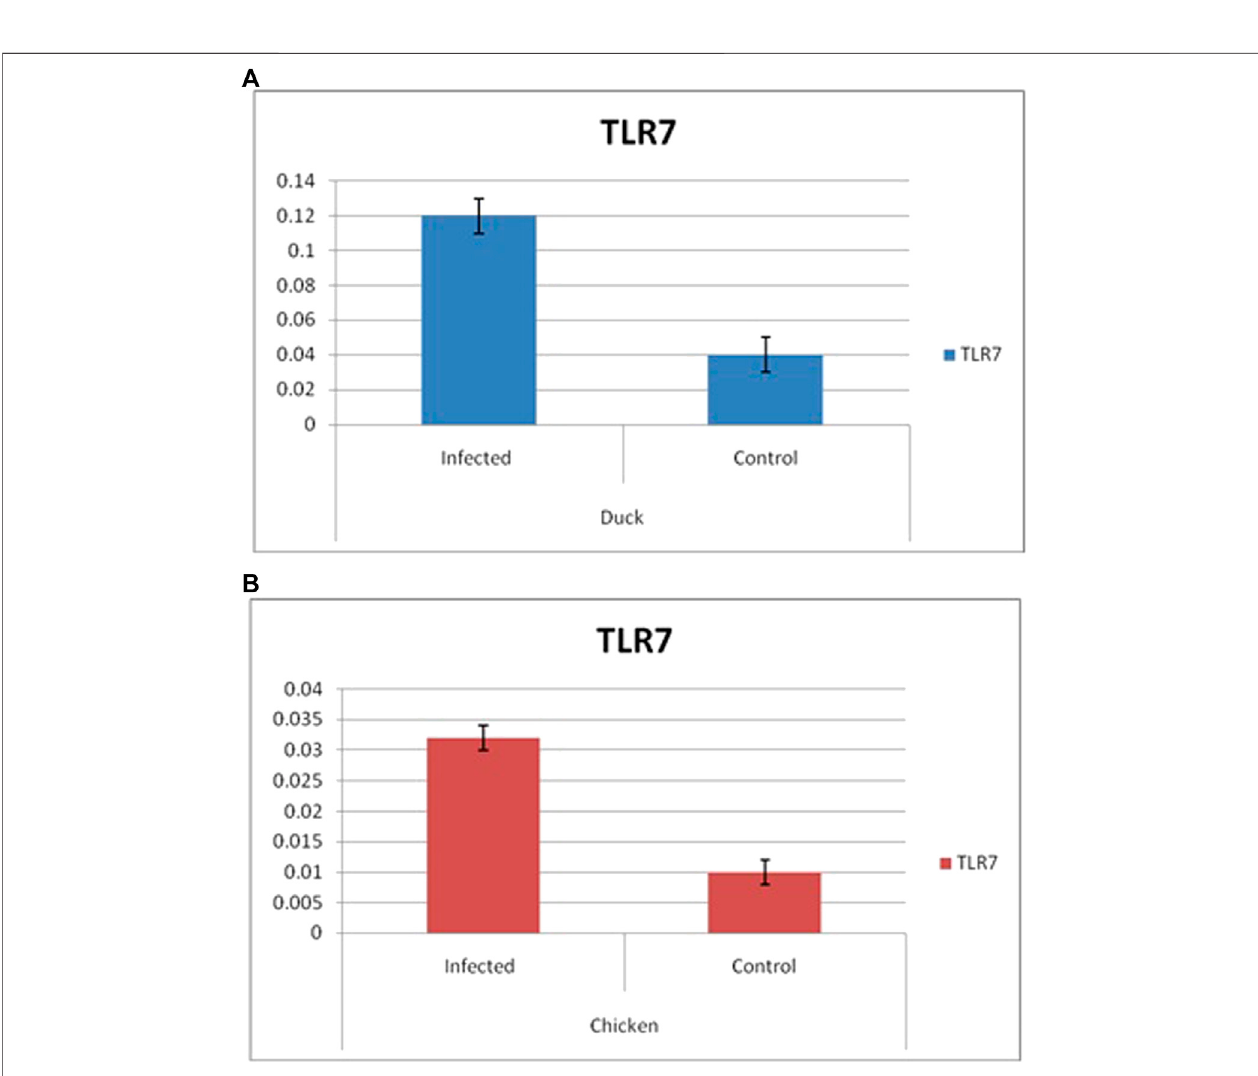
FIGURE 12 | Differential mRNA expression pro fi ling for TLR7 gene with respect to infected versus control Bengal duck and HB Chicken.